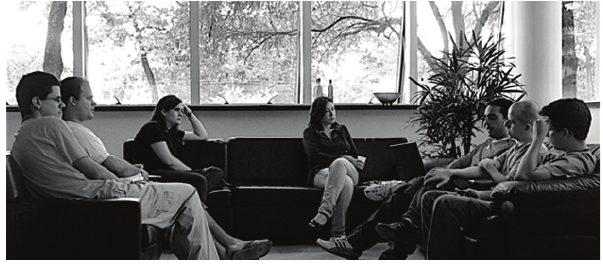
Figure 1. VOXAR Labs visualization team on a meeting. Recife is a beautiful tropical city in the northeast of